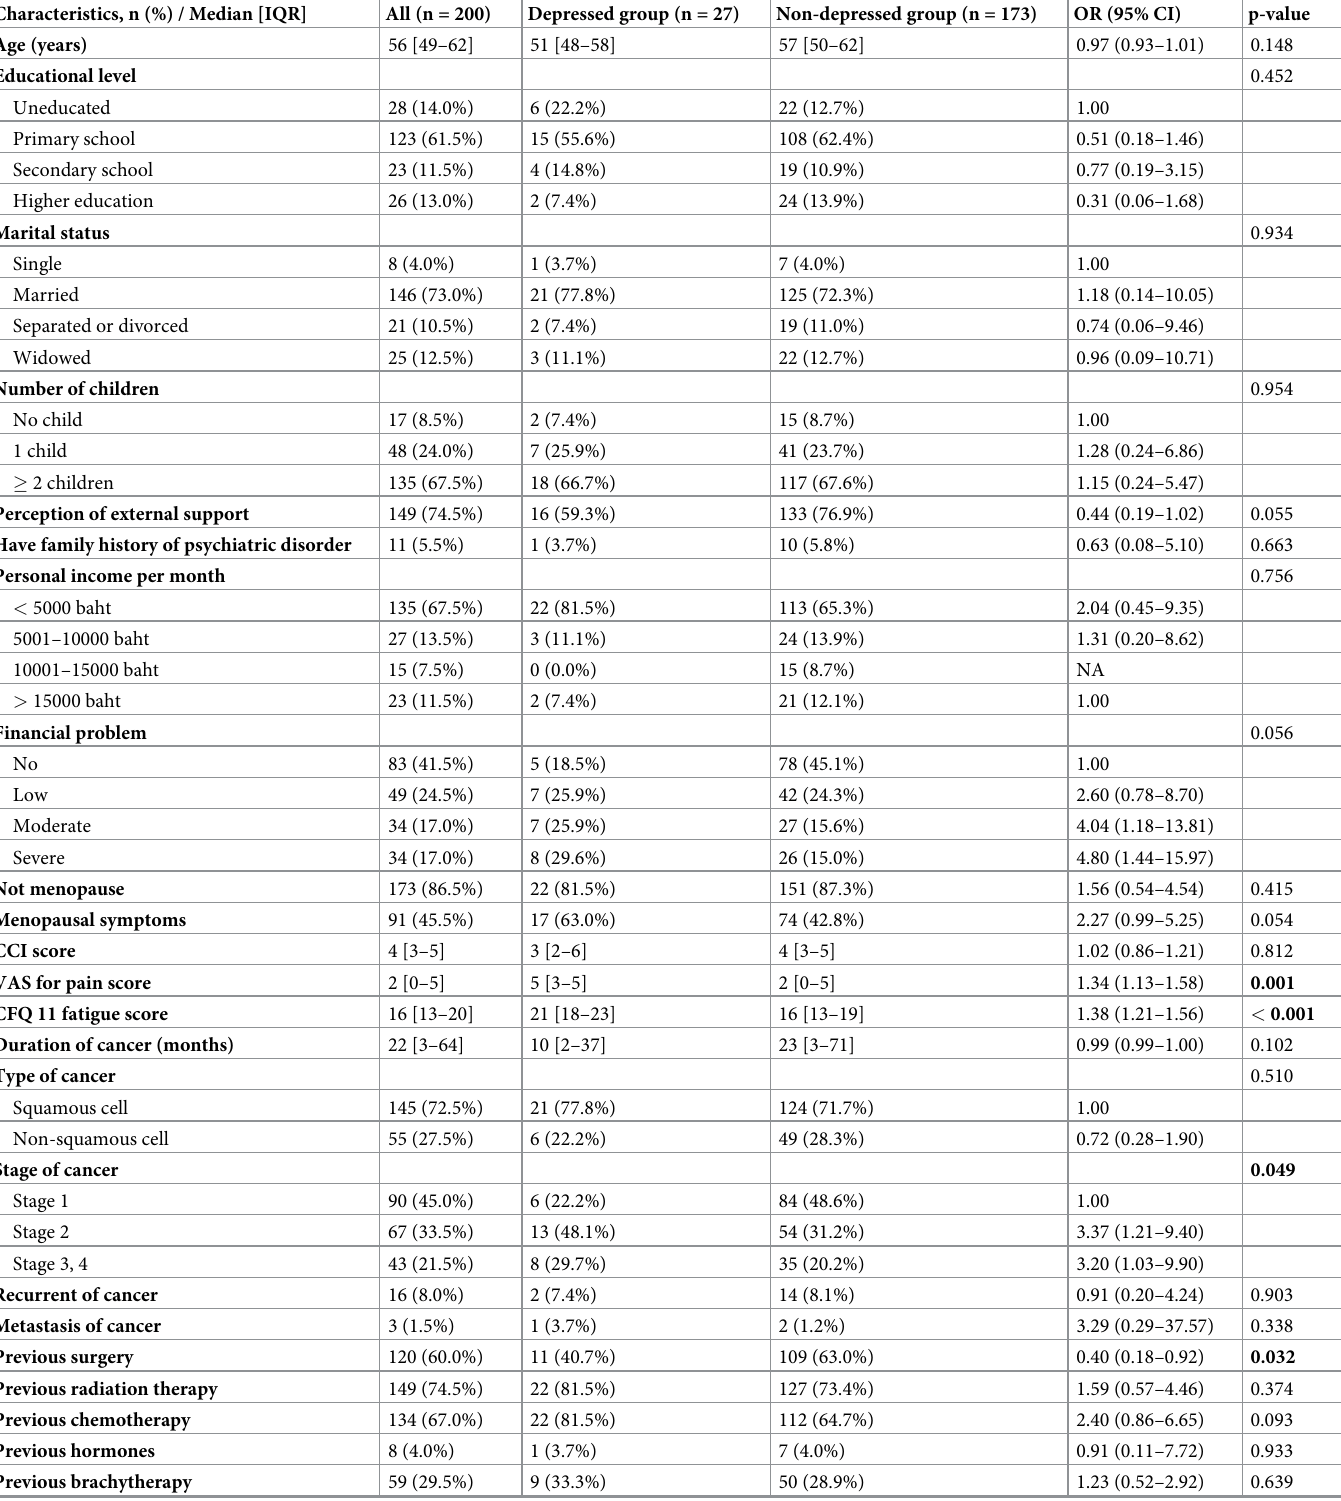
Table 2. Univariable logistic regression for potential associated factors of depressive disorder among cervical cancer patients. Characteristics, n (%) / Median